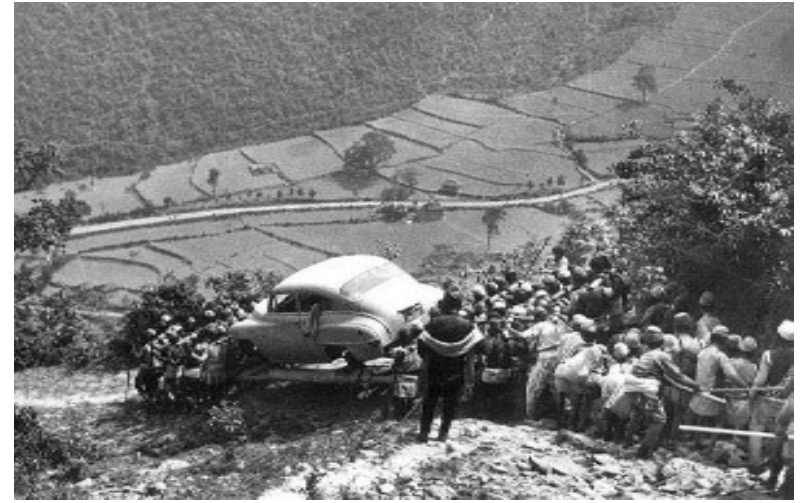
Figure 1. A sample image to be colorized showing how cars first arrived in Kathmandu valley of Nepal in 1957